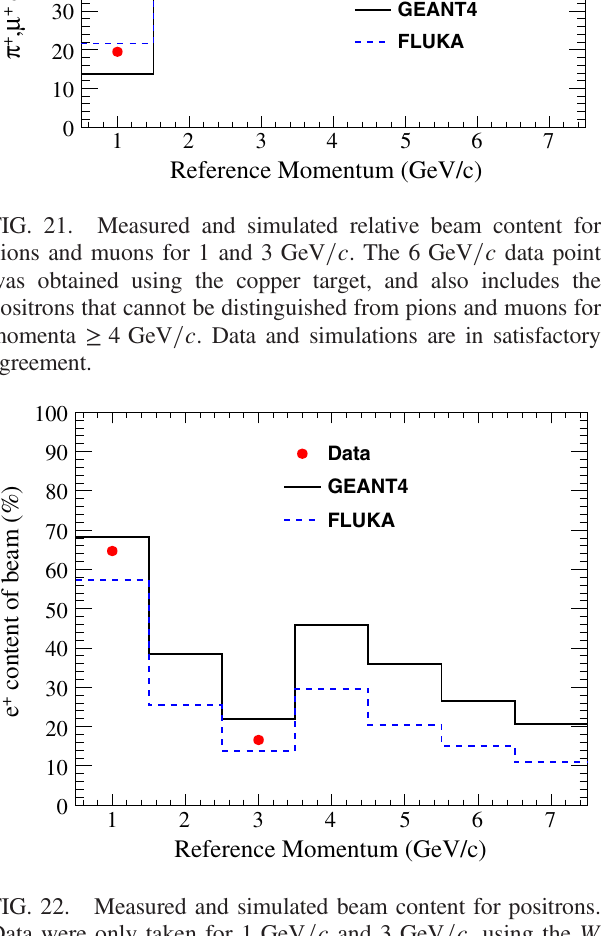
FIG. 22. Measured and simulated beam content for positrons. Data were only taken for 1 GeV =c and 3 GeV =c , using the W target. A quite satisfactory agreement with the simulations is demonstrated, with the differences in the beam composition not exceeding 20 % between the data and the average of the two Monte-Carlo